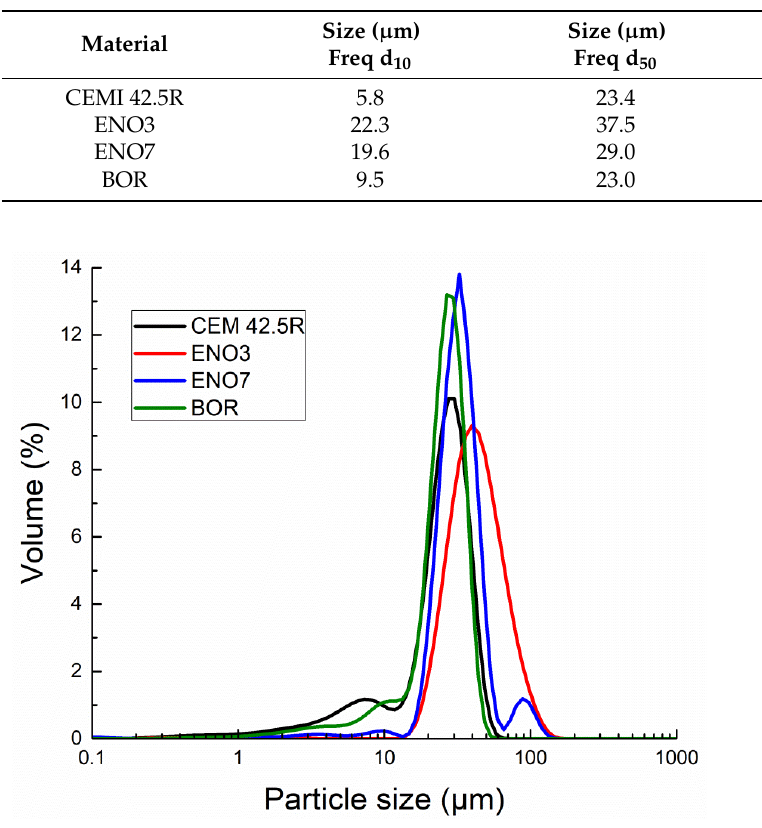
Figure 3. Particle size distribution of diatomaceous earth and CEMI 42.5R. A comparison with cement CEM I 42.5 R (the main peak at the particle size distri- bution curve was recorded for a pore diameter of 30.2 µm) showed that the powders of tested diatomaceous particles in the case of ENO 3 and ENO7 were coarser, nominally 39.8 µm and 32.7 µm, respectively. On the other side, the sample labeled BOR is slightly